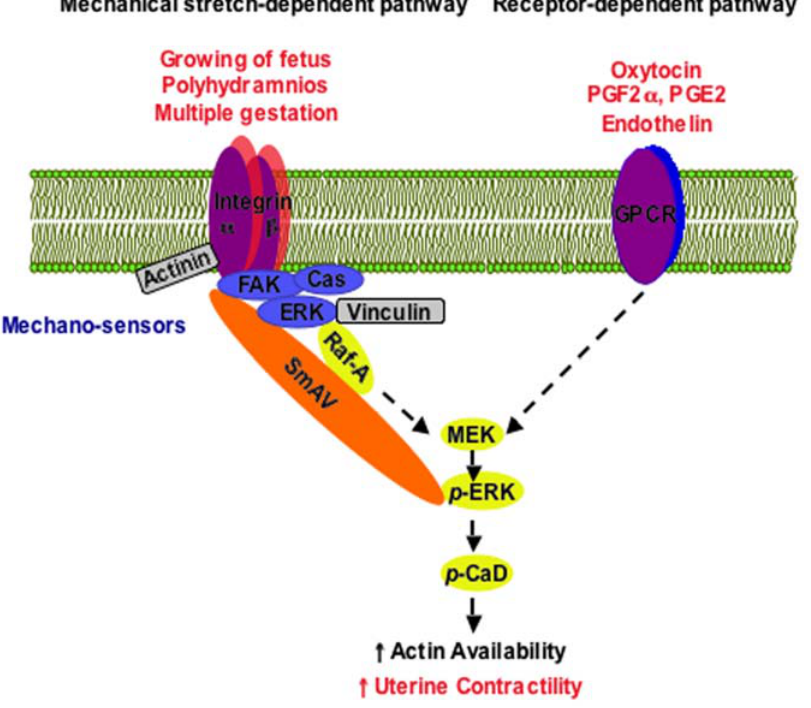
Figure 10. Model of signaling pathways involved in myometrial ERK activation. In addition to classical G-protein coupled receptors (GPCR) pathway described by others, data presented here suggest that the activation of ERK by focal adhesion signaling also promotes myometrial contraction and contributes to the initiation of labor. p: phosphorylation.